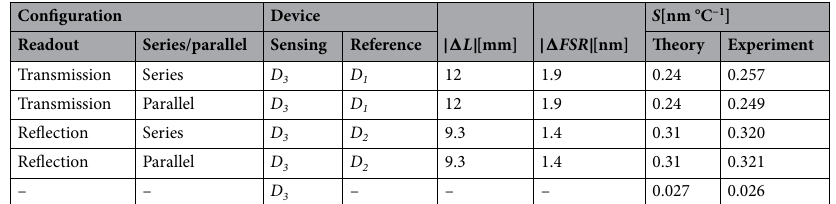
L S L R ), as well as their differences in (cid:31) L | | = −